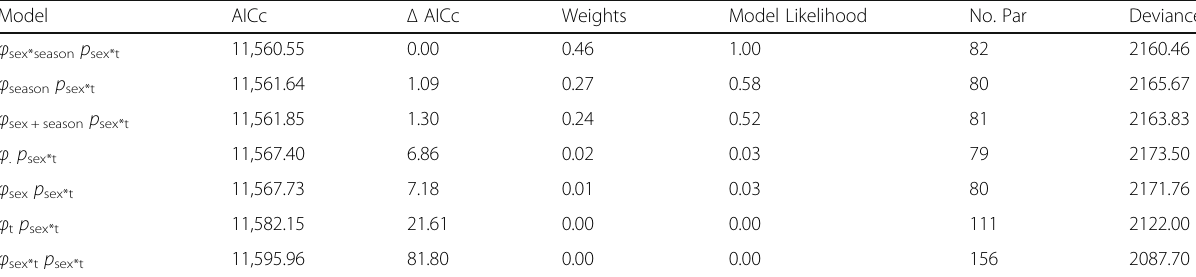
Table 1 The model selection of seven candidate models for adult apparent survival Model